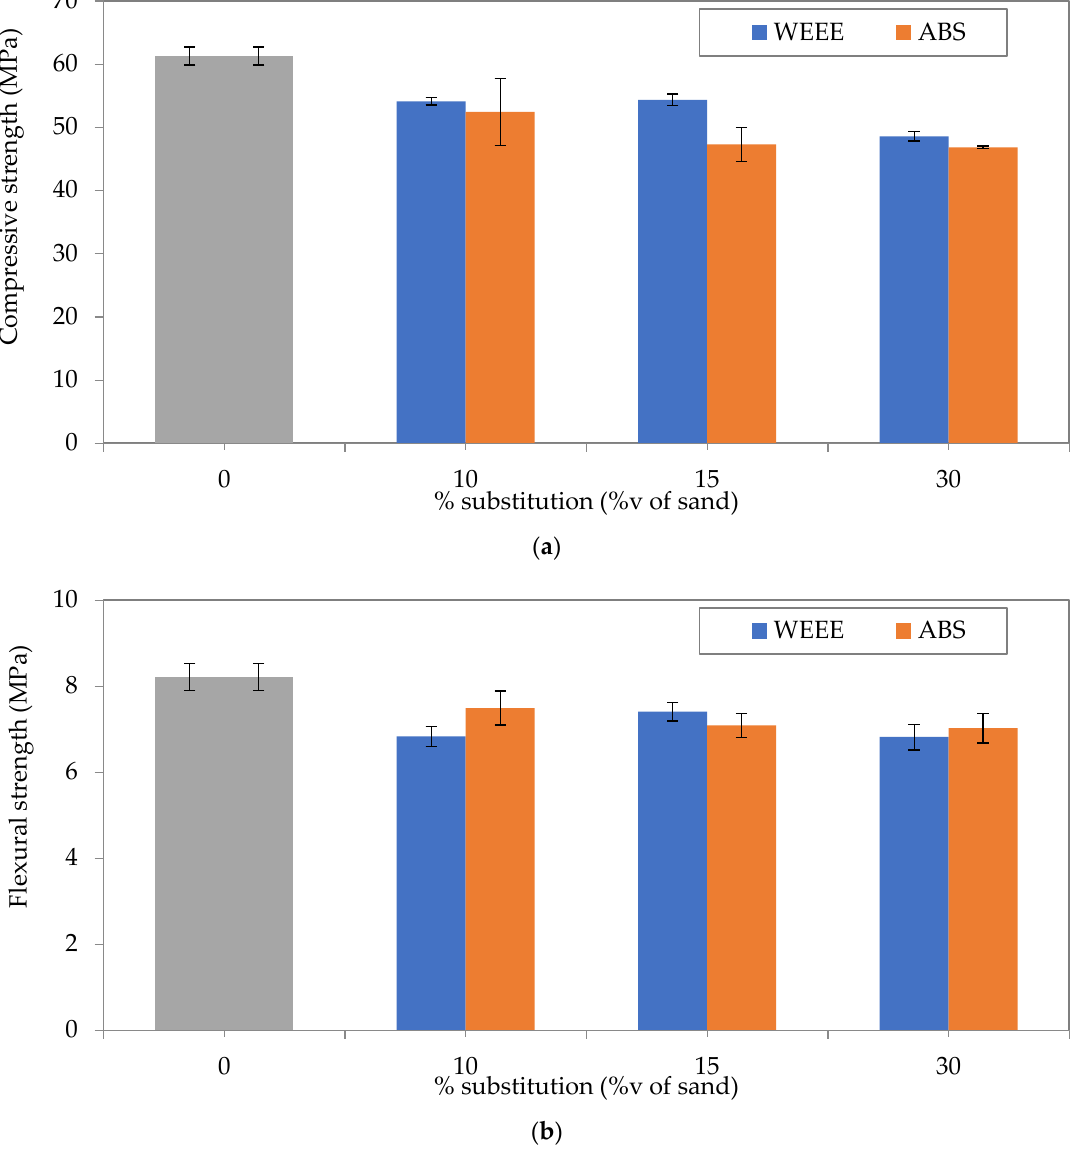
Figure 4. Compressive ( a ) and flexural ( b ) strength as a function of volume substitution of sand by plastic aggregates.